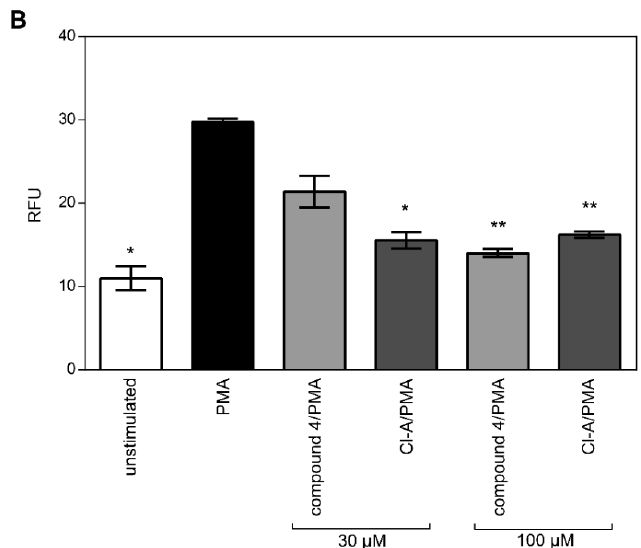
Figure 5. Inhibition of PAD-dependent NETs formation and release. ( A ) Human neutrophils isolated from healthy blood donors were allowed to adhere to coverslips pre-coated with poly-L-lysine. They were pre-incubated with DMSO alone, or with 100 µ M of compound 4 or Cl-amidine and then stimulated with PMA. Immunostaining for histone H2 was performed with allophycocyanin (APC) F(ab’) 2 goat anti-rabbit antibodies against histone H2A (red) with DNA counterstained with Hoechst 33258 (blue). Representative immunofluorescent images of 2 independent experiments are shown. ( B ) Human neutrophils isolated from healthy blood donors were allowed to adhere to a 24-wells plate coated with poly-L-lysine. They were pre-incubated with DMSO alone, or with either 30 μ M or 100 μ M of compound 4 or Cl-amidine and then stimulated with PMA. Supernatants were collected and quantification of extracellular DNA release was performed with the DNA-intercalating dye, Picogreen. Results are expressed as mean ± SD, with n ≥ 3 and the di ff erences were considered significant if (*) p < 0.05 or (**) p ≤ 0.01. RFU—relative fluorescence